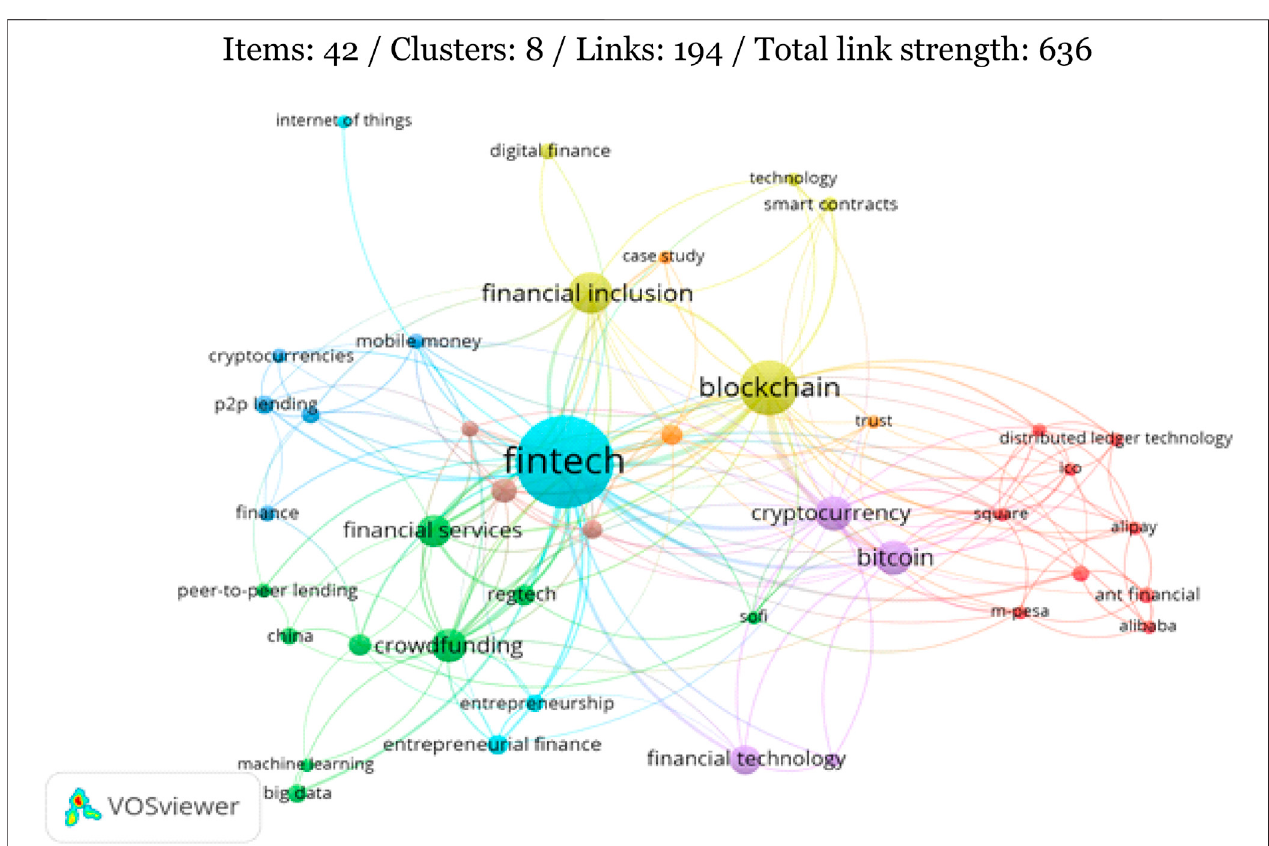
FIGURE 4 | (A) Network of keywords. (B) Density of keywords.